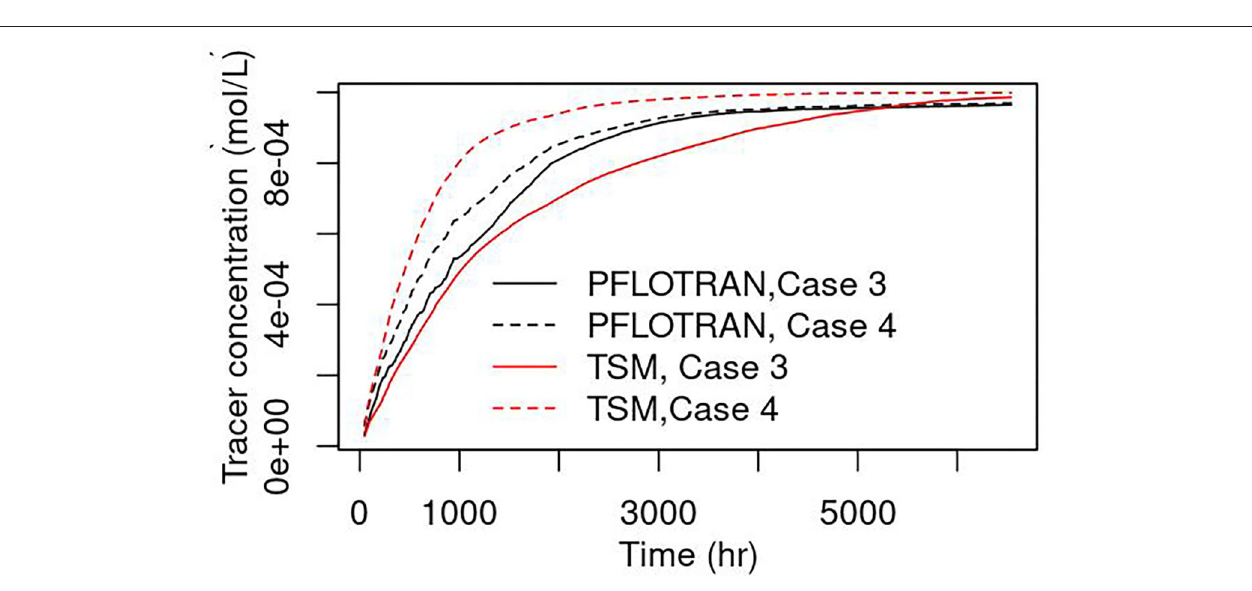
Table 2 . We summed up the mass of CH 2 O, NO 3 , and O 2